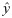
Spatial pattern of residuals for the family-level model.This shows the actual growth y of each tree minus its predicted growth y^. Blue individuals grew faster than expected by the model and red individuals grew slower. The residuals show clear spatial patterning.